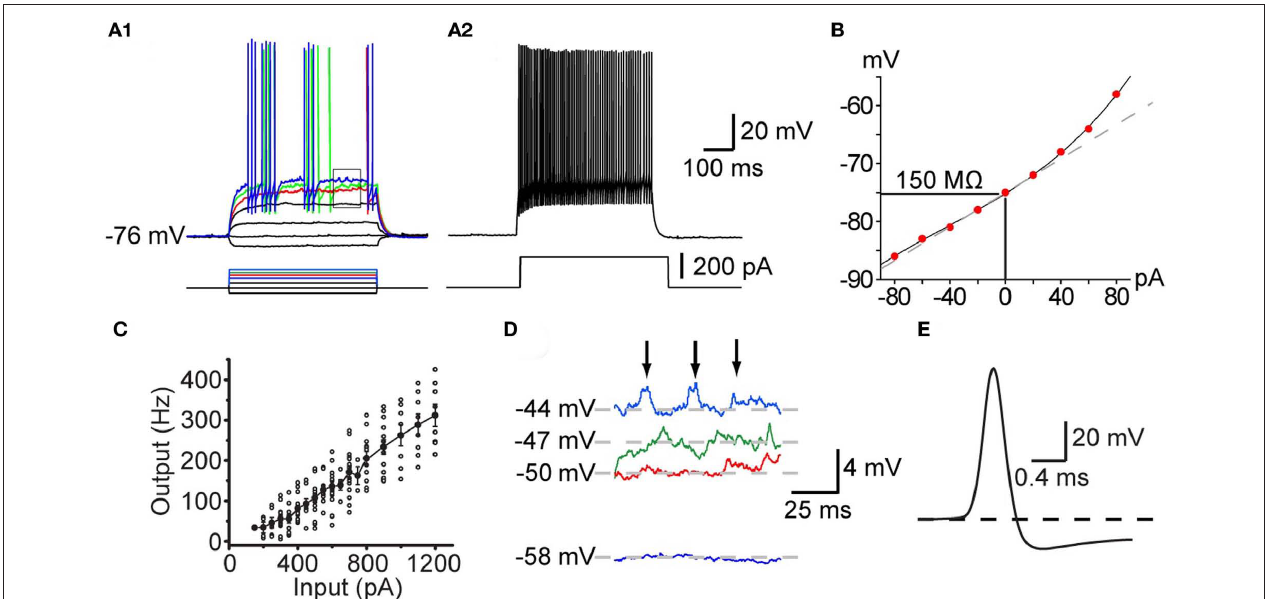
curve of the neuron illustrated in (A) . (C) IF curve plotted for a population of FSIs shows that they are capable of sustained firing in excess of 350 Hz. (D) Expanded view of the rectangle shown in (A1) illustrating voltage dependent subthreshold membrane oscillations that give rise to episodes of spiking in the chattering mode. (E) Expanded view of the singe spike shown in the red trace in (A1) illustrating the brief duration of the FSI action potential and the rapid onset of the deep spike